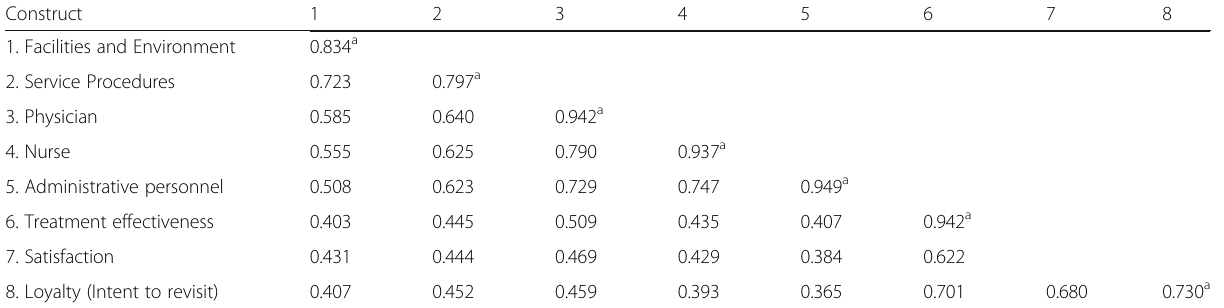
Table 3 Correlation between latent variables